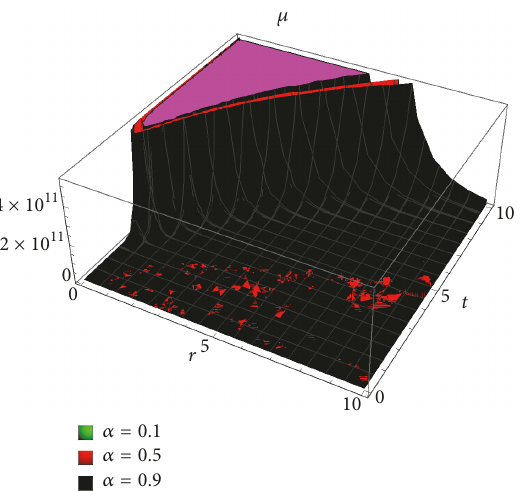
Figure 9: Tangential pressure behavior along 𝑟 and 𝑡 for 𝑟 0 = 0.5 and the different values of 𝛼 .